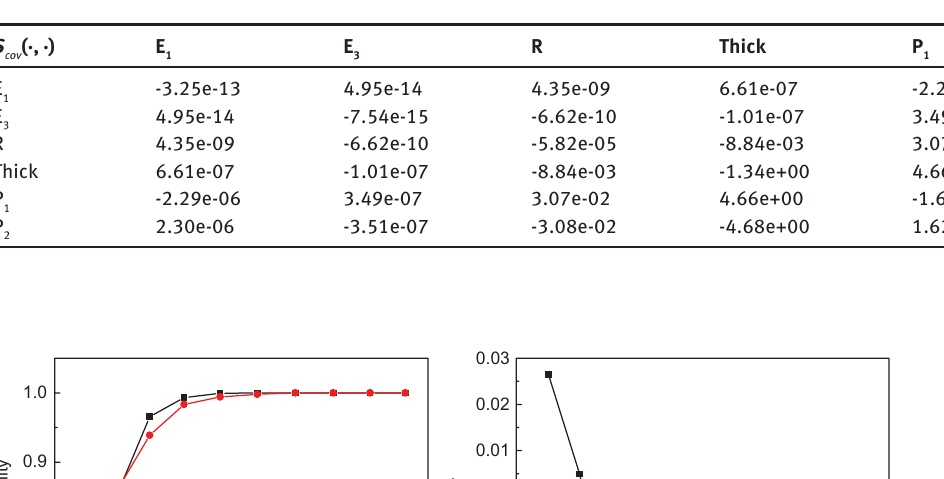
Table 6 Reliability sensitivity with the variance of random variables.